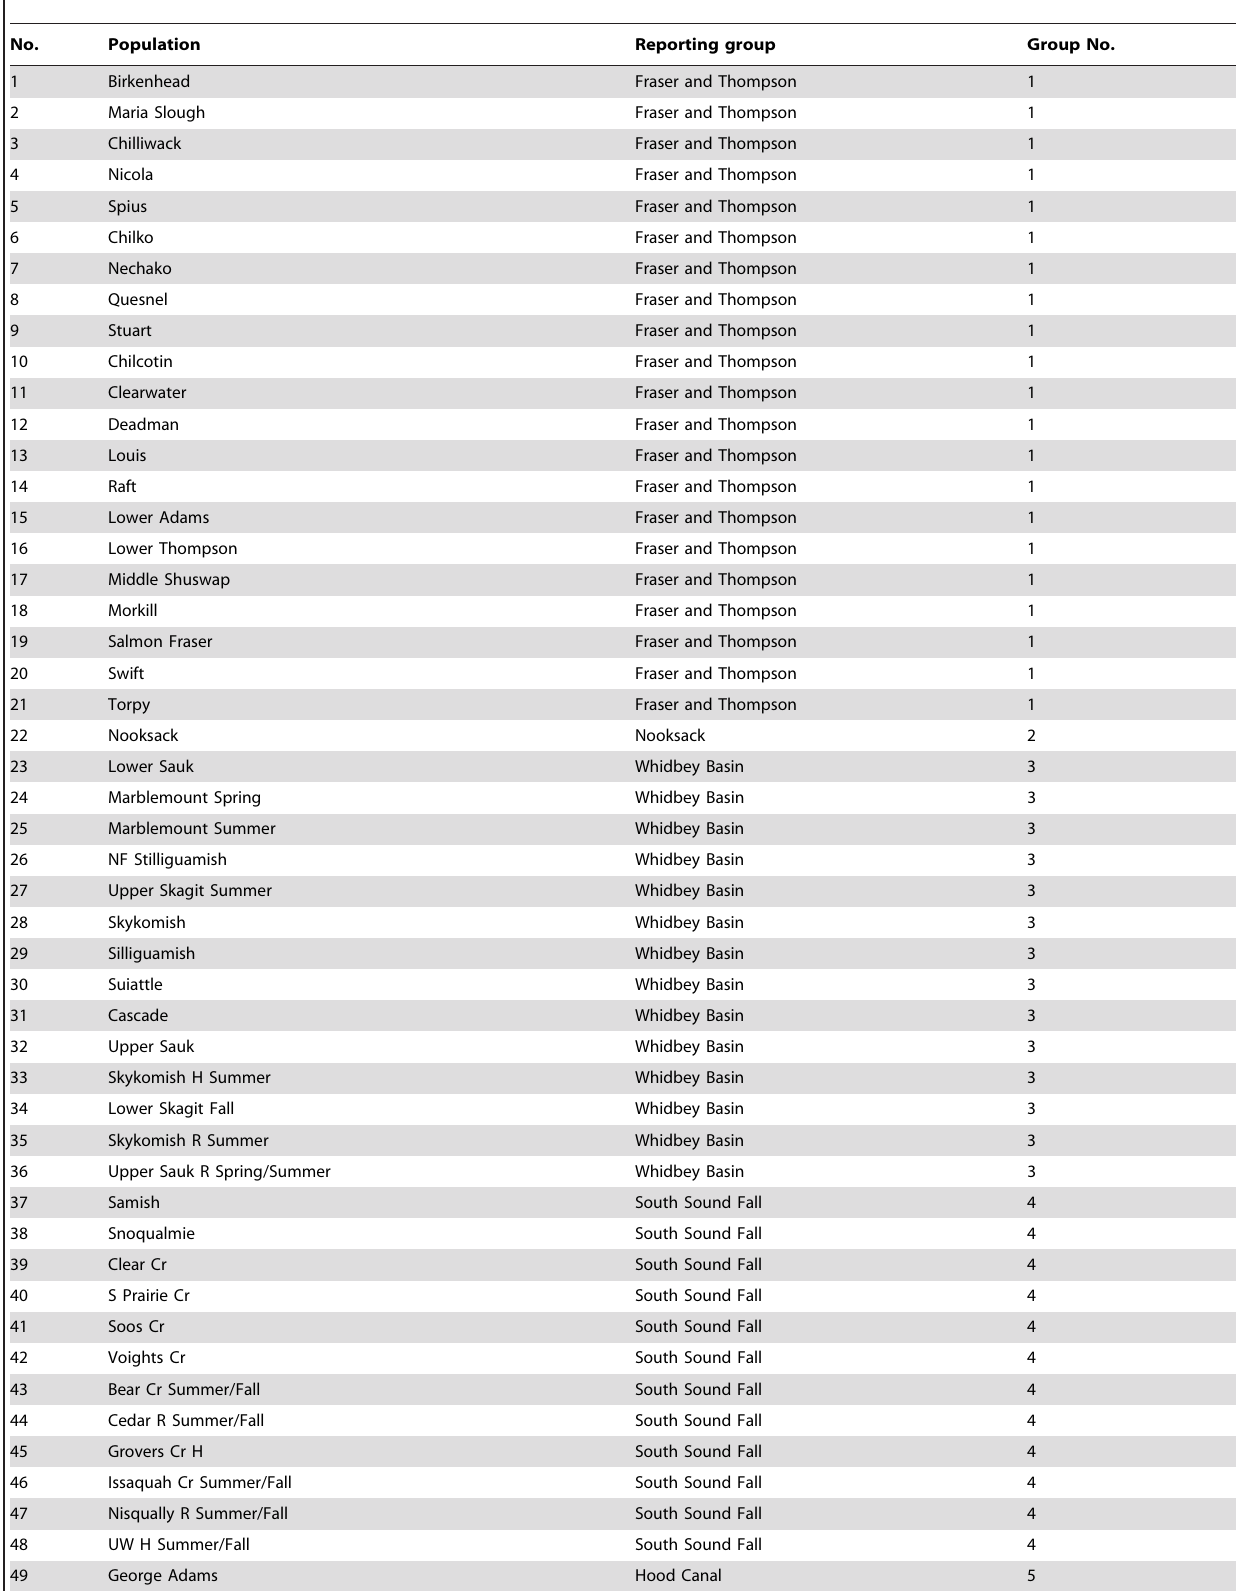
Table 1. Populations and reporting groups used as baseline for Puget Sound Chinook salmon individual assignment and mixture modeling for inferring group-specific BKD infection